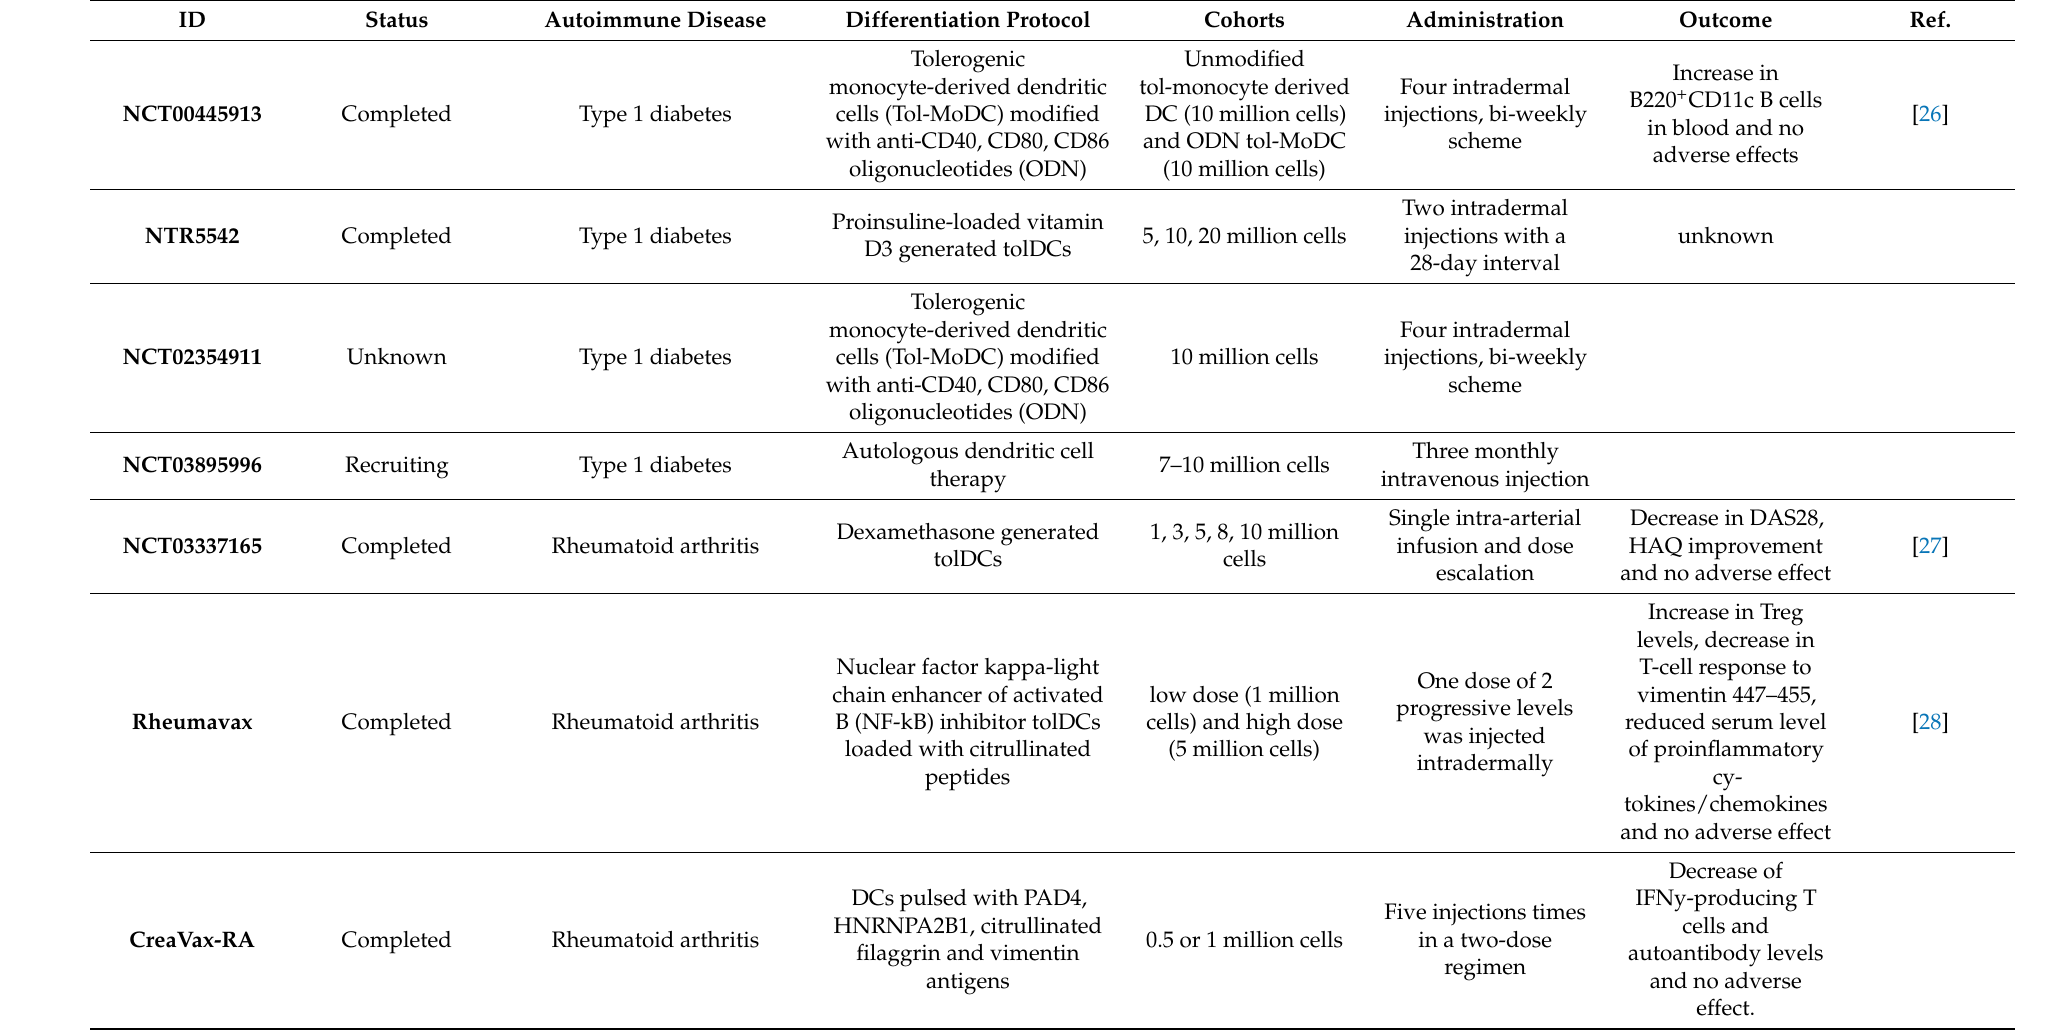
Table 1. Completed and ongoing clinical trials using different tolDC subsets to treat autoimmune